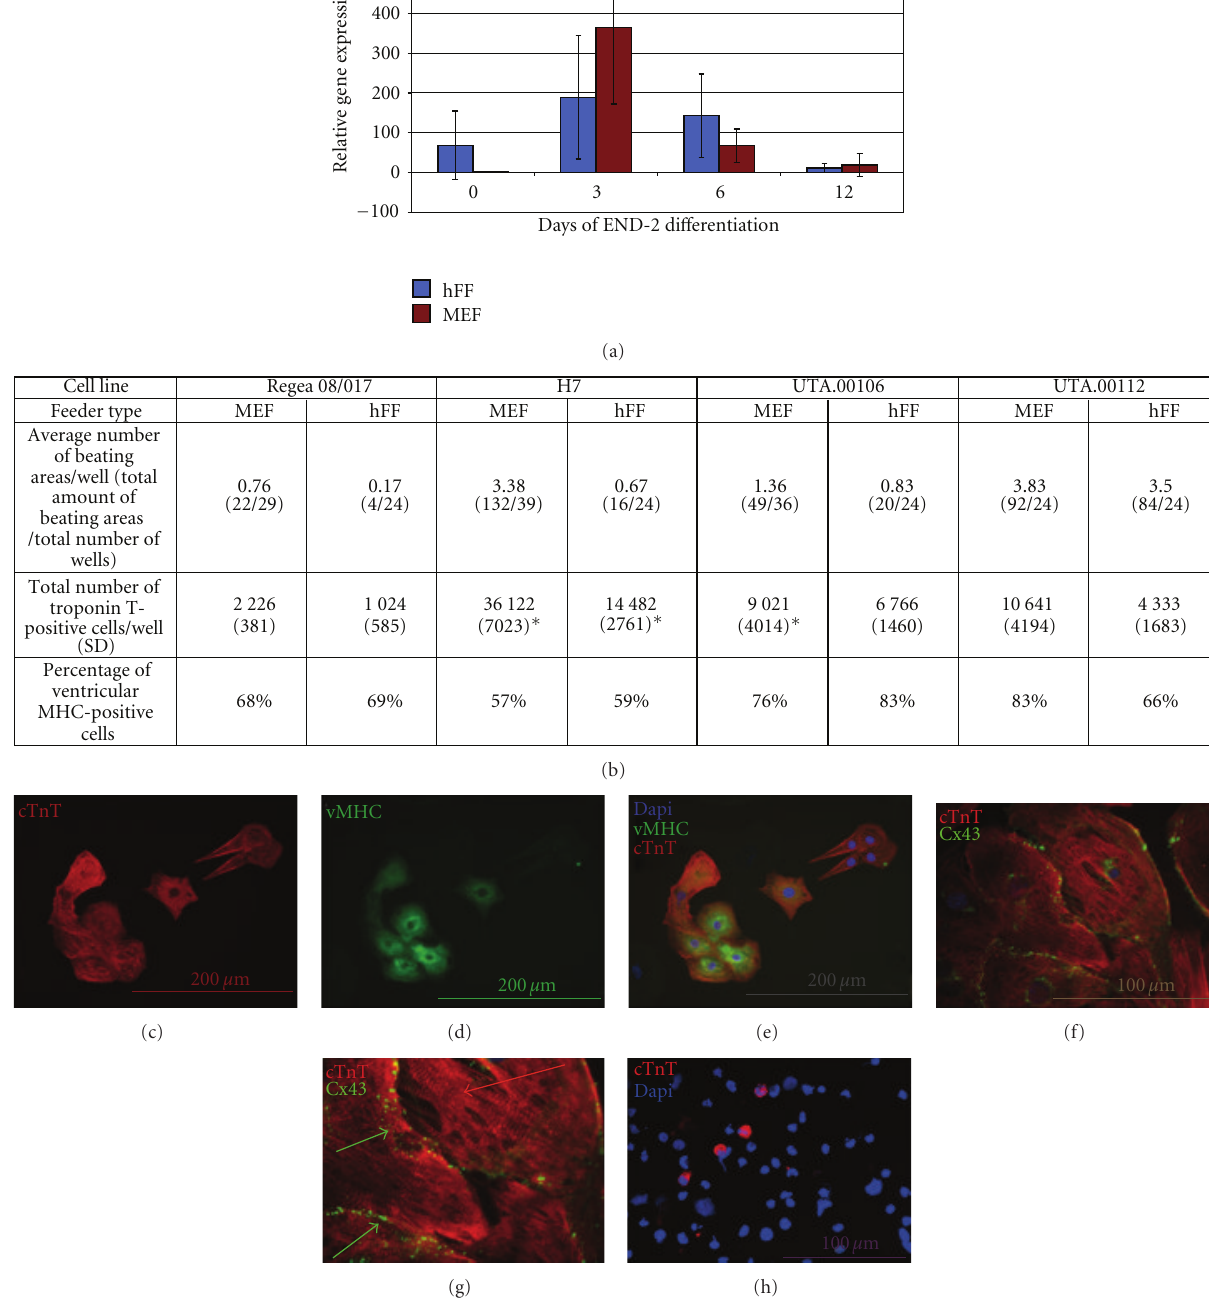
Figure 4: (a) Comparison of Brachyury T expression levels of MEF and hFF cultures. The di ff erences of Brachyury T expression levels between hFF and MEF cultures on days 3 and 6 are statistically significant. In addition, the di ff erence in expression levels of Brachyury T of MEF cultures between days 3 and 6 is statistically significant. Table in (b): Di ff erentiation data of H7, Regea 08/017, UTA.00106, and UTA.00112 cell lines on MEF and hFF feeder cells. For H7, the di ff erence between troponin T-positive cells is statistically significant, ( P < 0 . 01). (c–h) Characterization of the di ff erentiated cells. Troponin T (c), ventricular α -myosin heavy chain (d), and merged image with DAPI staining (e). Scale bar, 200 μ m. (f) Merged image with Troponin T (red) and Connexin 43 (green) revealing gap junctions between the cells. Scale bar 100 μ m. (g) Inset of image (f). (h) Cytospin slide of H7 (MEF) stained by troponin T (red) and DAPI (blue). Scale bar, 100 μ